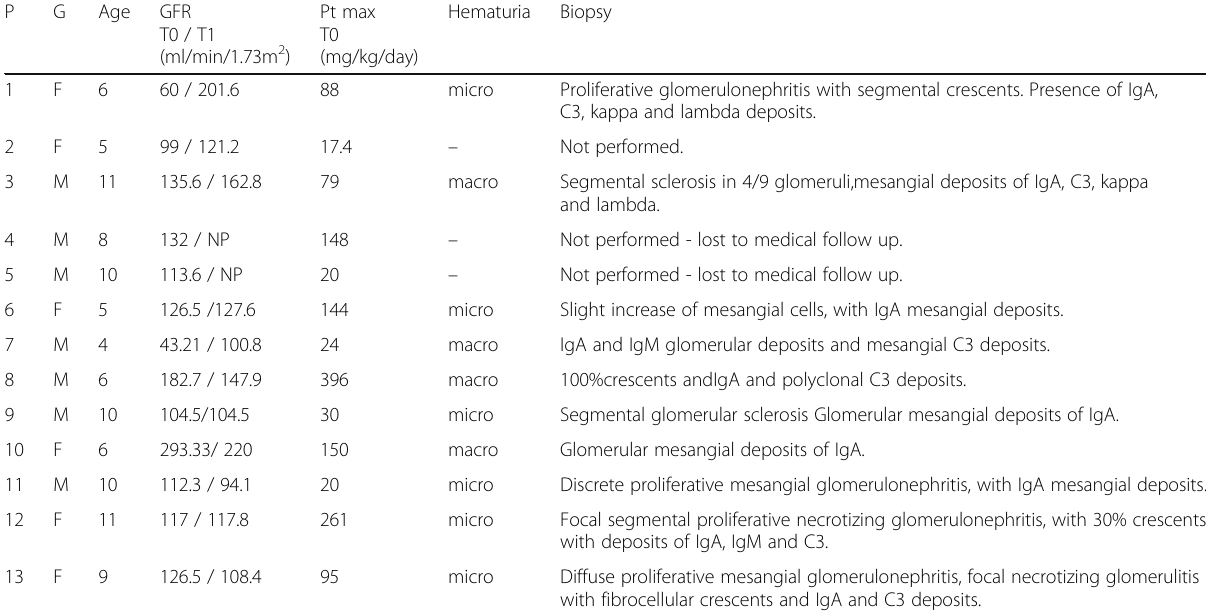
Table 2 Characteristics of the thirteen patients with renal impairment due to Henoch-Schönlein Purpura in use of azathioprine